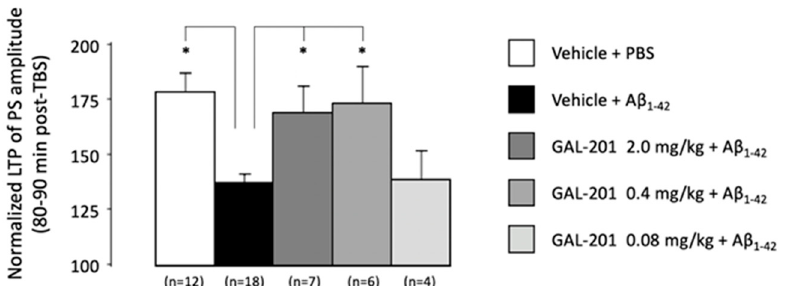
Figure 10. In vivo LTP in rats with i.c.v. applied A β 1-42 and subcutaneously applied GAL-201. Bar chart detailing the LTP of PS amplitude 80–90 min after theta burst stimulation for the various treatment groups. Data are expressed as a percentage of the pre-TBS control ± SEM. In animals subject to i.c.v injection of 6 µ L oligomeric A β 1-42 , a preadministration of s.c. GAL-201 0.08–2 mg/kg produced a dose-dependent protection against oligomeric A β 1-42 -induced deficits in hippocampal LTP, the highest GAL-201 doses (0.4 and 2 mg/kg) bringing post-TBS responses towards those observed in animals receiving i.c.v. PBS. (* p < 0.05).